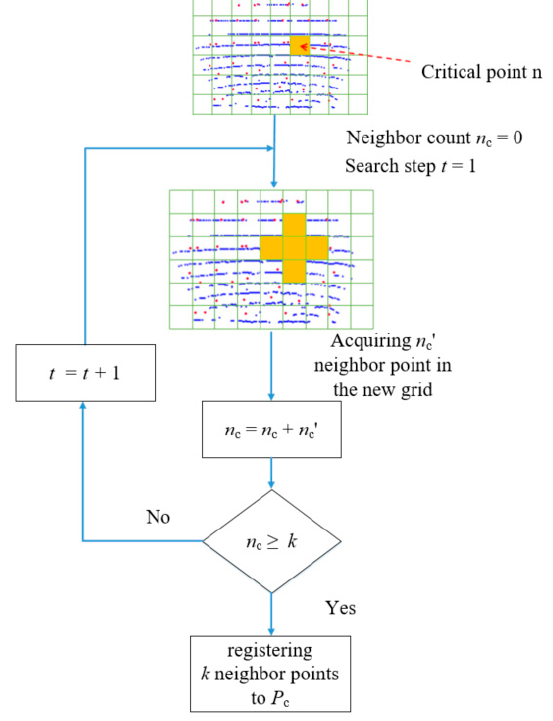
Figure 4. The grid ‐ based dynamic nearest neighbors algorithm.